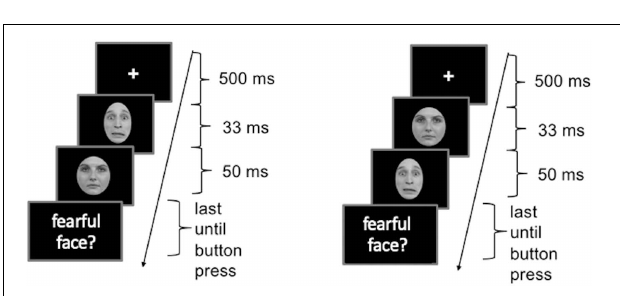
FIGURE 6 | Schematic illustration of the procedures in the forced choice experiment in Study 2. (A) Masked condition. (B) Unmasked condition. Face images were obtained from the Radboud Faces Database (Langner et al., 2010) and are reprinted in line with the guidelines of the